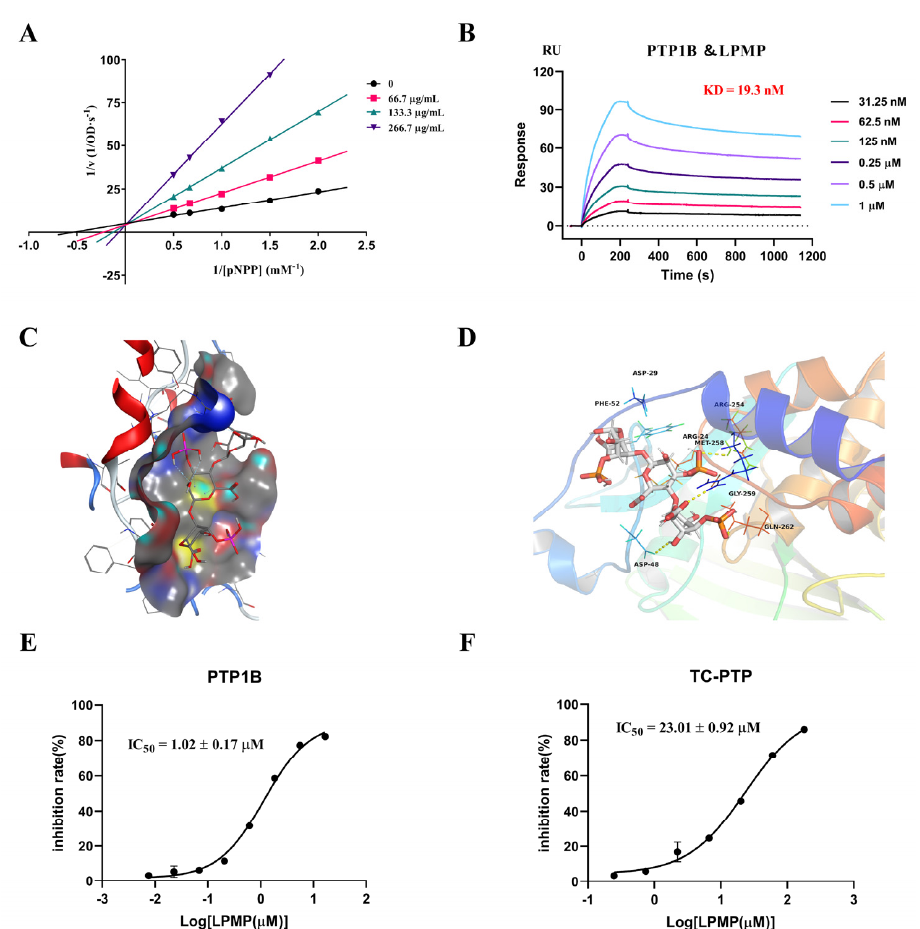
Figure 2. Interaction of LPMP with PTP1B. ( A ) Lineweaver Burk data analysis of LPMP inhibition of PTP1B. The reciprocal of the initial reaction rate (1/[V]) corresponds to the reciprocal of the pNPP concentration (1/[pNPP]) in the presence of different concentrations of LPMP. ( B ) Interaction of LPMP with PTP1B immobilized on the CM5 chip. ( C ) The binding site of PTP1B interacting with LPMP mode was shown as a molecular surface structure using MOE software. ( D ) A comprehensive view of the hydrogen bond and hydrophobic interactions of PTP1B-LPMP was displayed by Pymol software. ( E ) The IC 50 value of LPMP to PTP1B. ( F ) The IC 50 value of LPMP to TC-PTP.